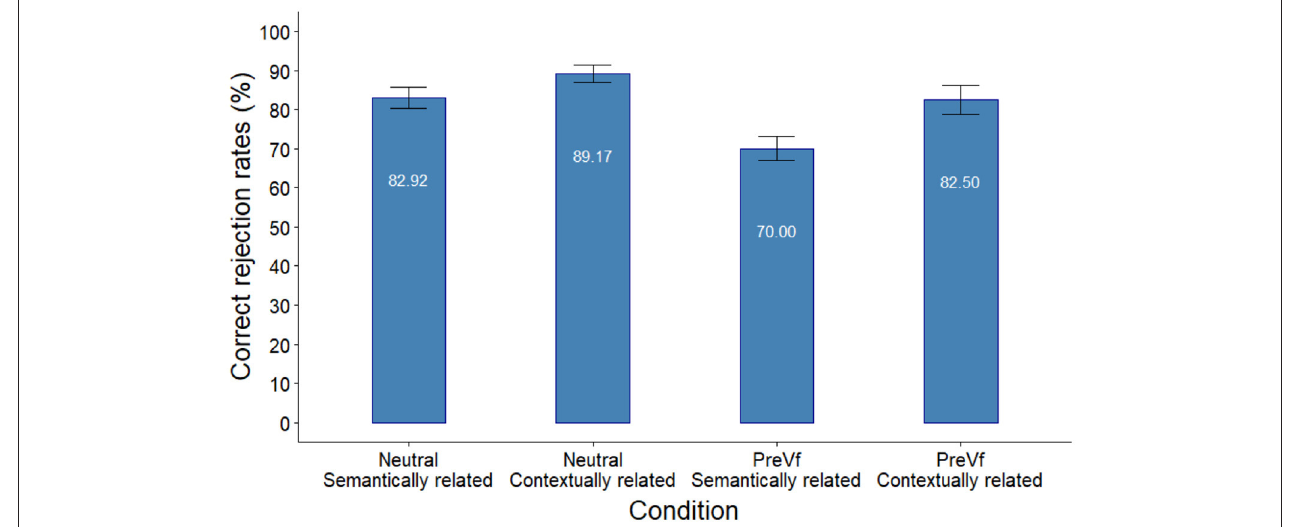
FIGURE 4 | Accuracy rates in the different probe conditions in Experiment 2. Error bars indicate the standard error of the mean.